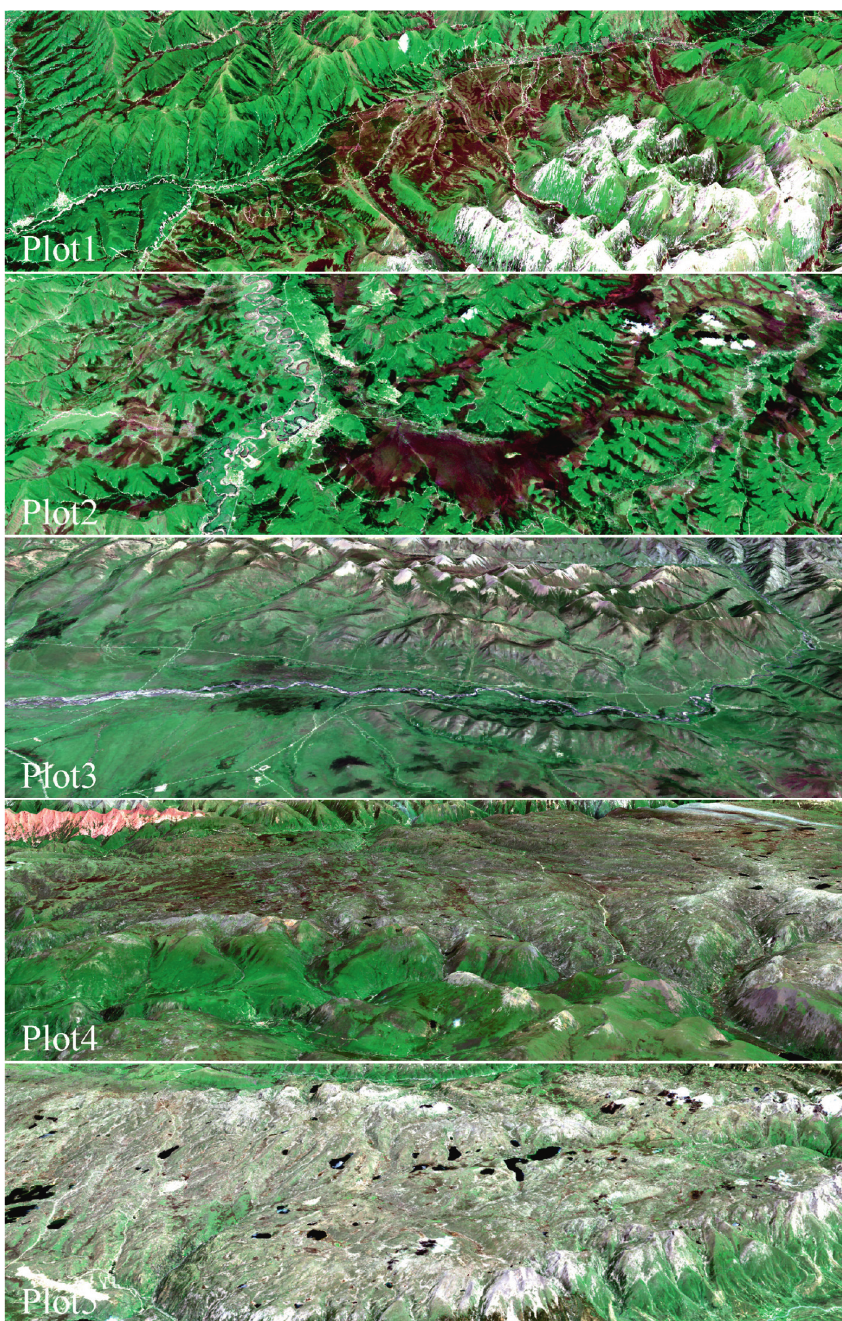
Figure 3: Three-dimensional geographical features of the alpine wetland plots